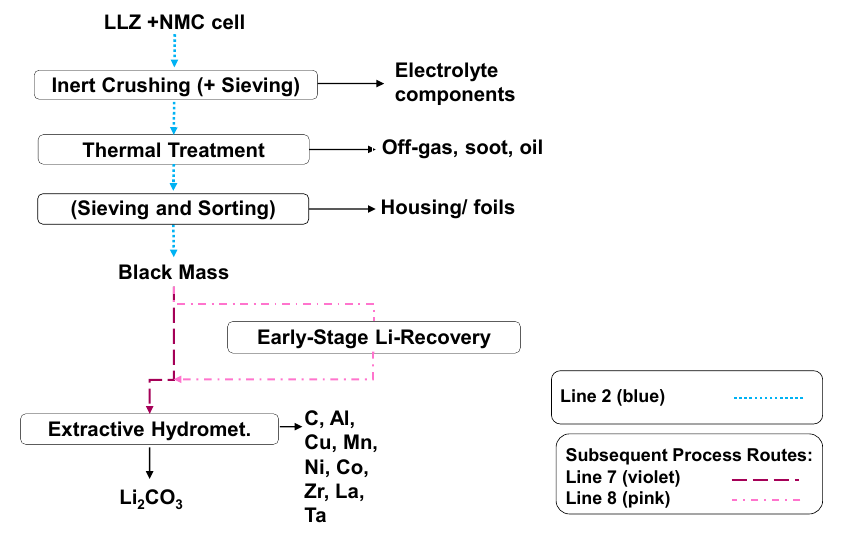
Figure 4. Experimental plan for a suitable LLZ + NMC recycling. C represents both graphite, active charcoal, and soot.